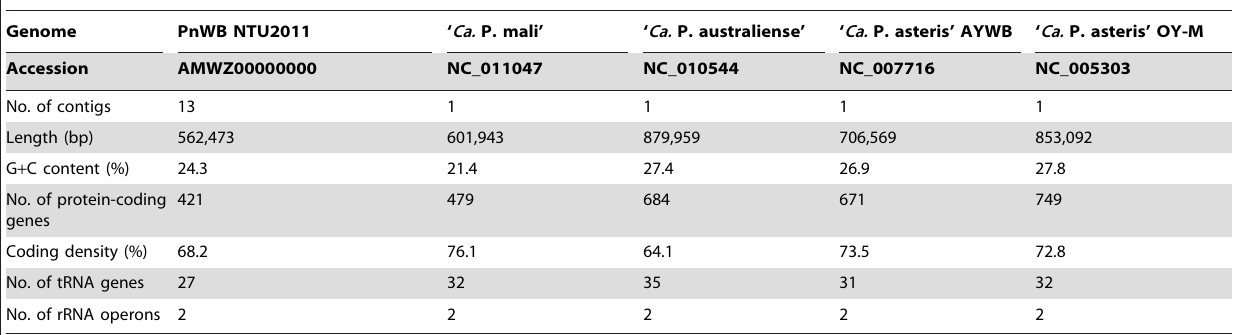
Table 1. Genome assembly statistics.